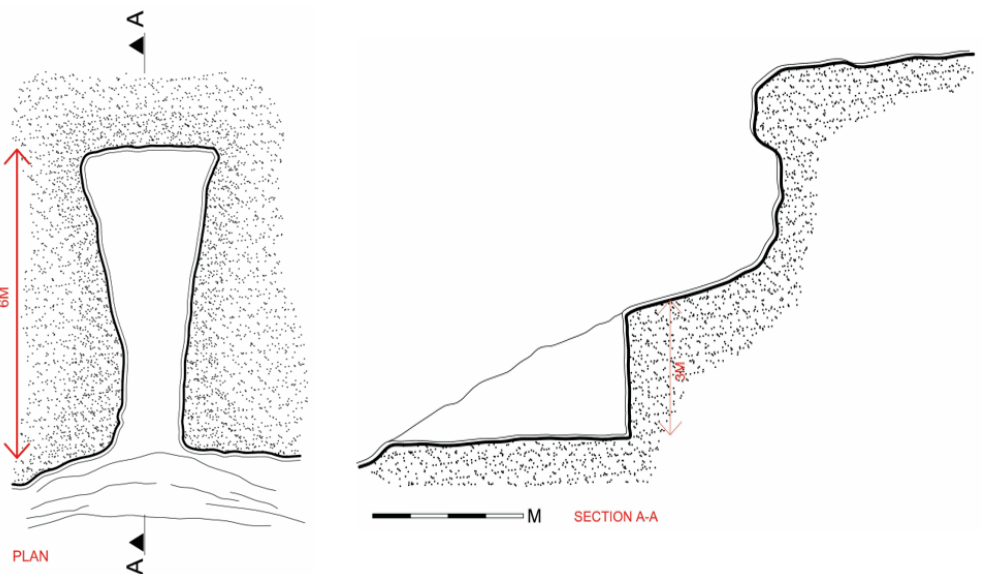
Figure 17. The first stage of excavation (excavation of entrance trench, i.e., Kicheh) in cross-section and plan view.